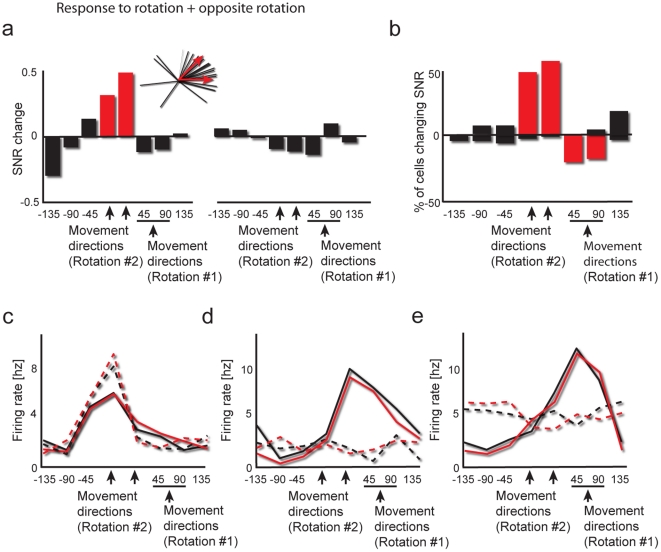
The lack of simultaneous representation after learning rotation followed by opposing rotation.(a) SNR changes for rotation followed by opposite rotation tasks (n = 140 cells). Notation same as Figure 2c. Note that SNR elevation is restricted to the directions used during the second rotation. (b) Percentage of neurons significantly increasing or decreasing their SNR after learning (during the TO epoch). Red marks directions where a significant portion of the neurons changed their SNR. (c–e) Examples of single neurons, notation same as Figure 4. (c) Neuron with a pre-learning PD that was close to the directions used during the second rotation. (d–e) Two neurons whose pre-learning PDs were close to the directions used during the first rotations.